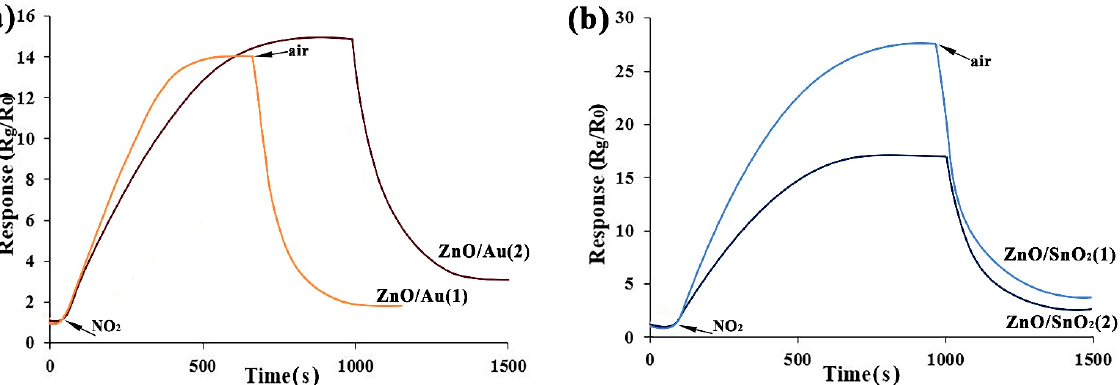
Figure 6. The resistance-to-time curves characterizing the responses of ( a ) ZnO/Au and ( b ) ZnO/ SnO 2 samples at 200 °C to NO 2 with a concentration of 10 ppm. The resistance values are normalized by an initial value of R 0 recorded in background air.